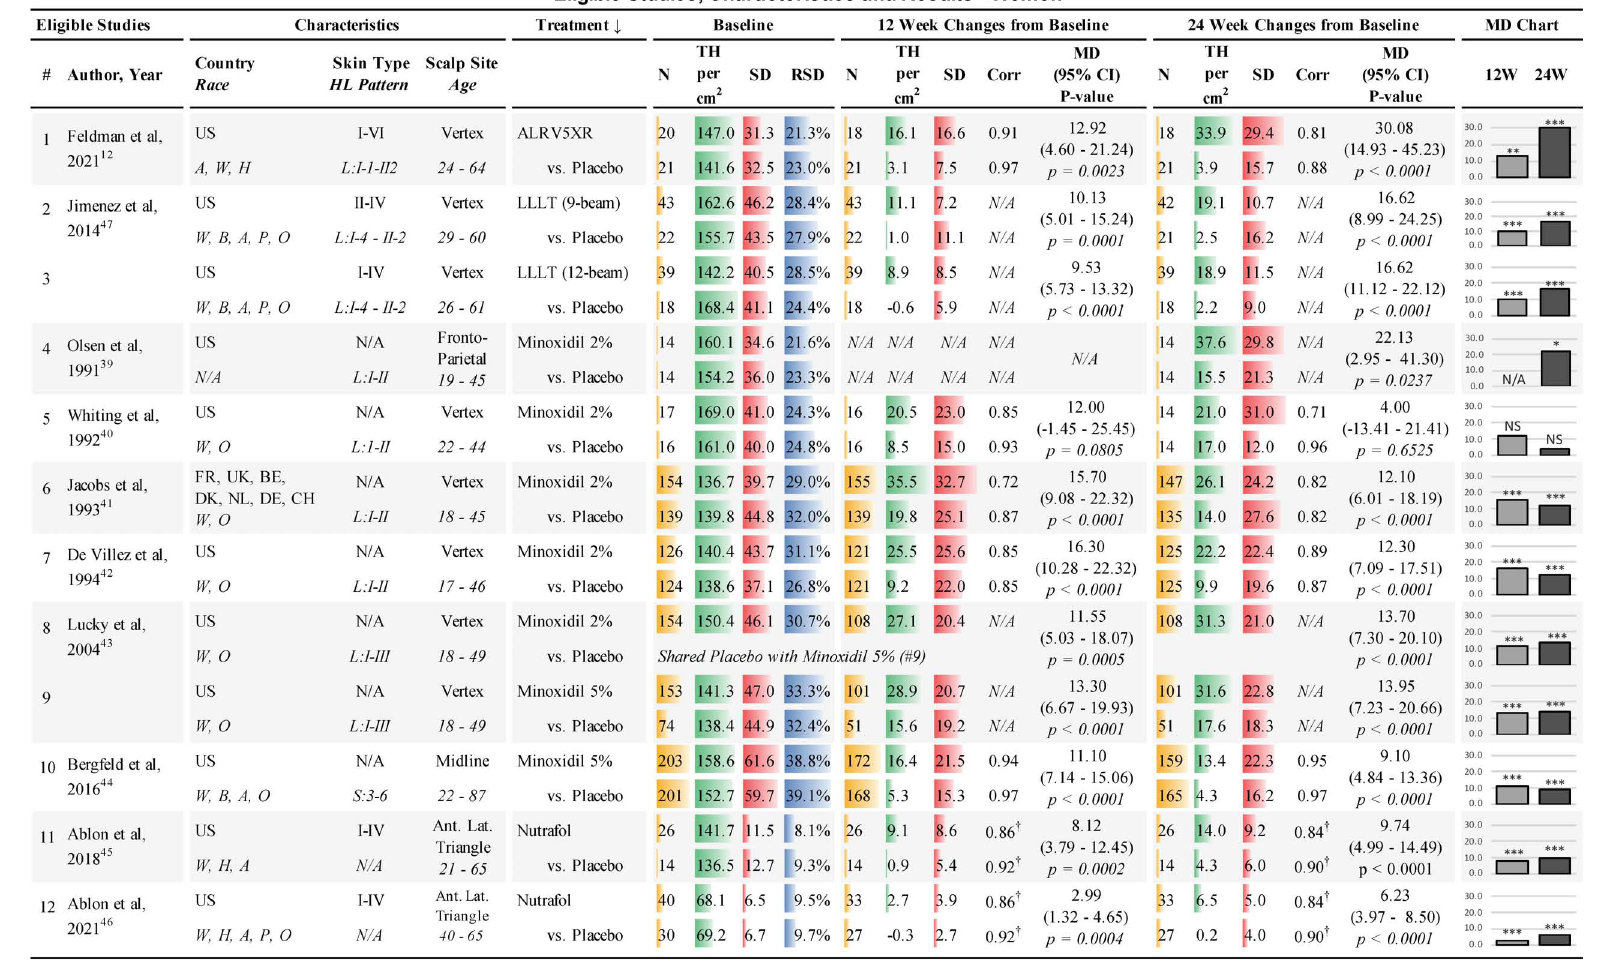
FIGURE1 Eligible studies, characteristics, and results — Women. ↓ , primary sort by treatment (secondary by year of study); Country: US, United States of America; FR, France; UK, United Kingdom; BE, Belgium; DK, Denmark; NL, Netherlands; DE, Germany; CH, Switzerland. Race: W, White; H, Hawaiian; A, Asian; B, African; P, Pacific; O, other; Skin Type, Fitzpatrick I-VI; HL, hair loss pattern (Ludwig or Savin scale); Scalp Site is observed position in study; Age, study-cohort age range; N, sample population in each arm; TH, terminal hair (mean count per cm 2 ); SD, standard deviation; RSD, relative SD (SD/TH); Corr, correlation factor; † , imputed corr; MD, mean difference between treatment and Placebo; 95% CI = 95% confidence interval; 12W and 24W, 12 and 24 weeks of treatment; bar chart colors for N, TH, SD, RSD, and MD chart are for illustrative purposes; N/A = not available, NS = not statistically significant; ∗ , ∗∗ , and ∗∗∗ are frequentist statistically significant P -values < 0.05, < 0.01, and < 0.001,